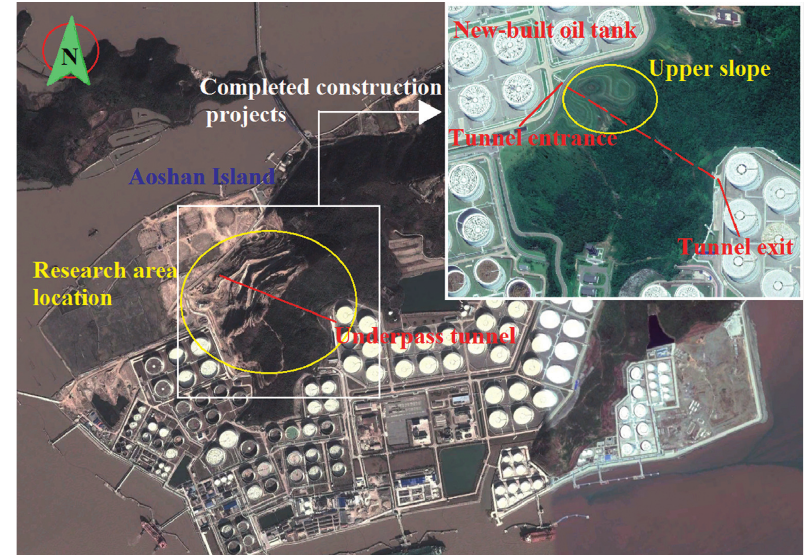
Figure 1: Layout of the national petroleum reserve base in Zhoushan.